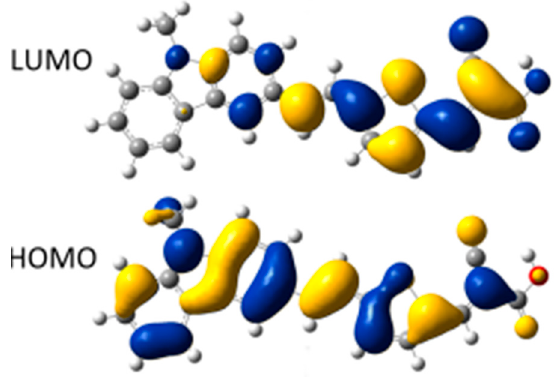
Figure 4. HOMO and LUMO orbital of 1A , as predicted by TD-DFT calculations (B3LYP/6-31G(d)) (grey = carbon, red = oxygen, blue = nitrogen, yellow = sulfur and white = hydrogen). Table 1. Lowest energy transition ( λ max ) for the compound studied, in DCM, as measured experimentally and calculated using TD-DFT.